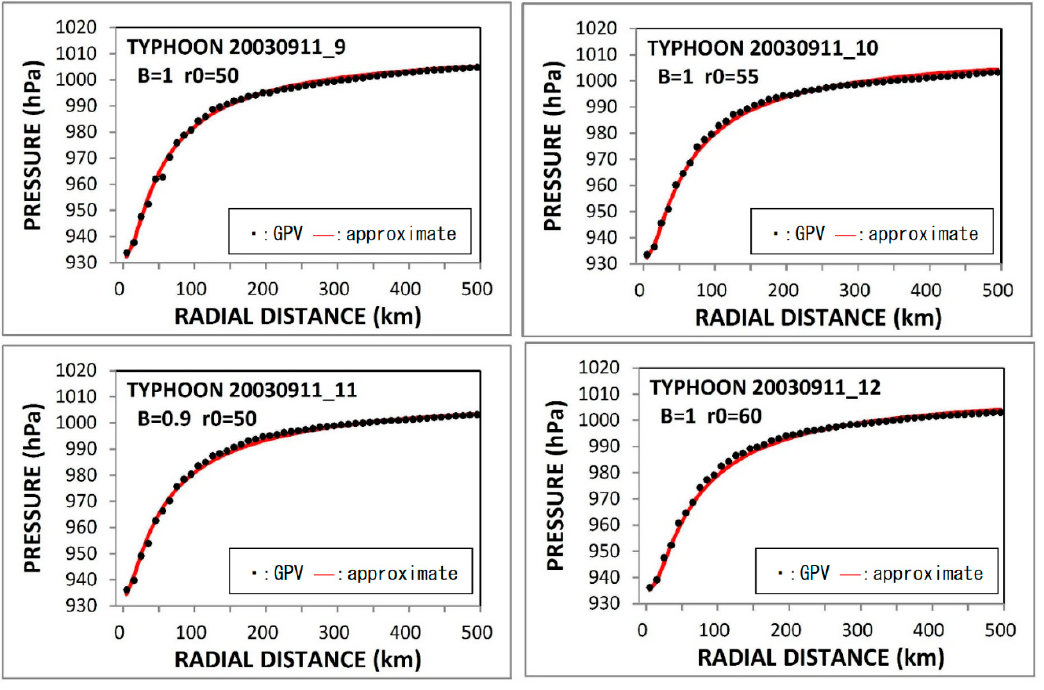
Figure 10. Variable calculation result of the typhoon model (Typhoon Maemi).